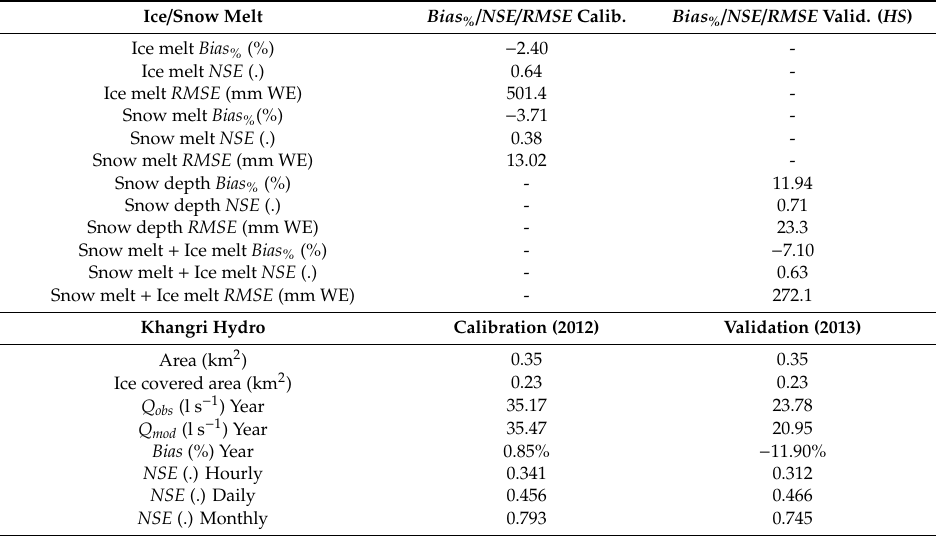
Figure 4. West Khangri Nup hydro station (5332 m asl). Observed (2012–2013) and simulated discharge 2010–2014 (30 June) using Poli-Hydro . We report the simulated daily contributions to flow, i.e., ice/snow melting, rainfall, and base flow, together with the precipitation input of snowfall/rainfall and air temperature. Table 4. West Khangri Nup. Statistics of modeled ice melt, snow melt, and snow depth, calibration (ice melt and snow melt), validation (snow depth), and mixed (ice melt + snow melt, i.e., total melt available). See Figure 2 for observed and estimated values and dates. Hydro station. Statistics observed and modeled by Poli-Hydro , calibration and validation period. NSE: Nash–Sutcliffe efficiency. Ice/Snow Melt Bias % / NSE/RMSE Calib.